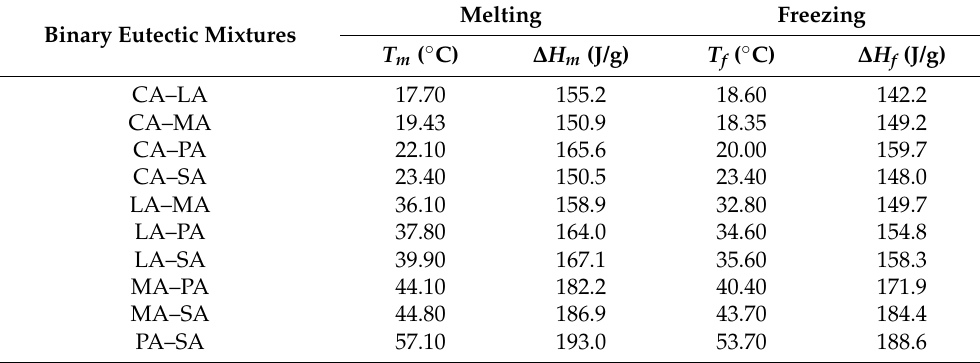
Figure 4. DSC curves of ten fatty acid binary eutectic mixtures. Table 4. Experimental thermal performance parameters of ten fatty acid binary eutectic mixtures.